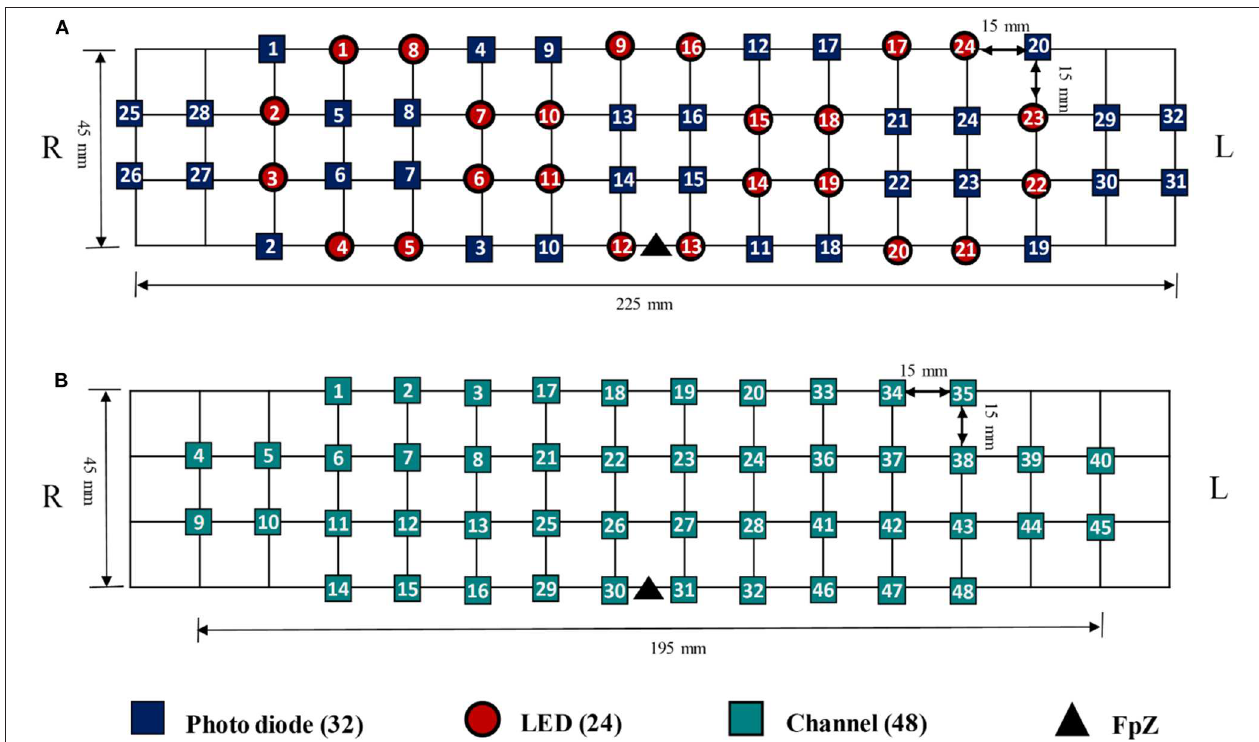
FIGURE 3 | (A) The placement of Emitter and detector, (B) channel configuration with FpZ as a reference point based on the 10–20 international